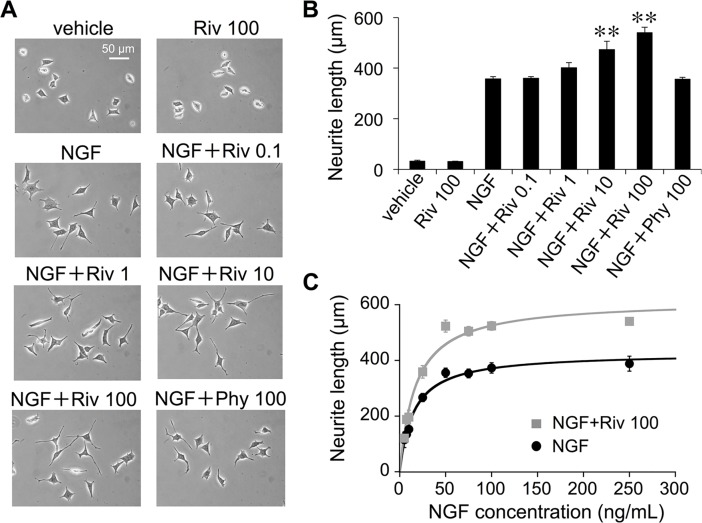
Riv enhances NGF-induced neurite outgrowth in PC12 cells.PC12 cells were treated for 24 h with NGF with or without Riv. (A) Culture images at a magnification of 400×. Scale bar: 50 μm. (B) Neurite length was determined as indicated in the Materials and Methods section. Values represent the mean ± SD for all PC12 cells contained within five randomly chosen fields for each condition. All experiments were repeated at least three times **p < 0.01 versus NGF. (C) Neurite lengths in the presence of various concentrations of NGF (0–250 ng/mL).